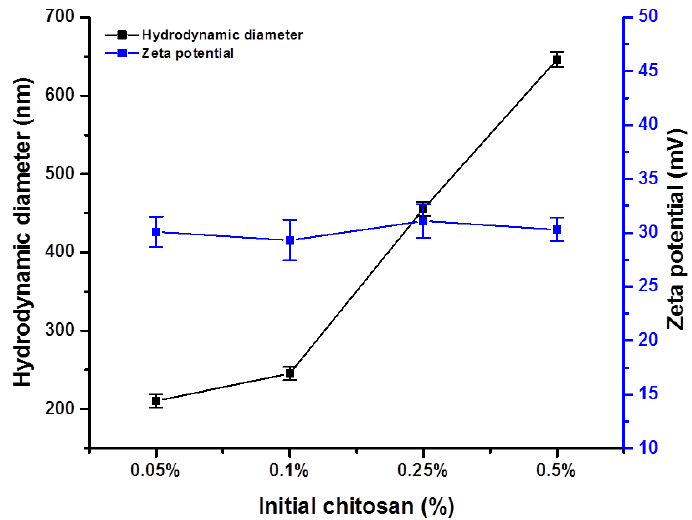
Figure 1. Hydrodynamic diameter and zeta potential of synthesized chitosan nanoparticles (ChNPs) at different initial chitosan concentrations.